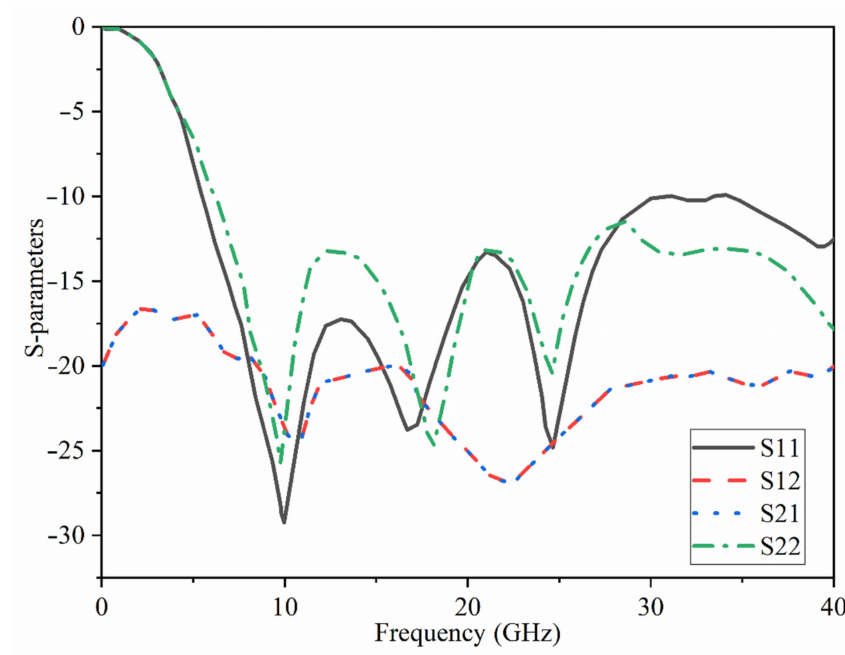
Figure 7. The antenna’s simulated reflection and transmission coefficients